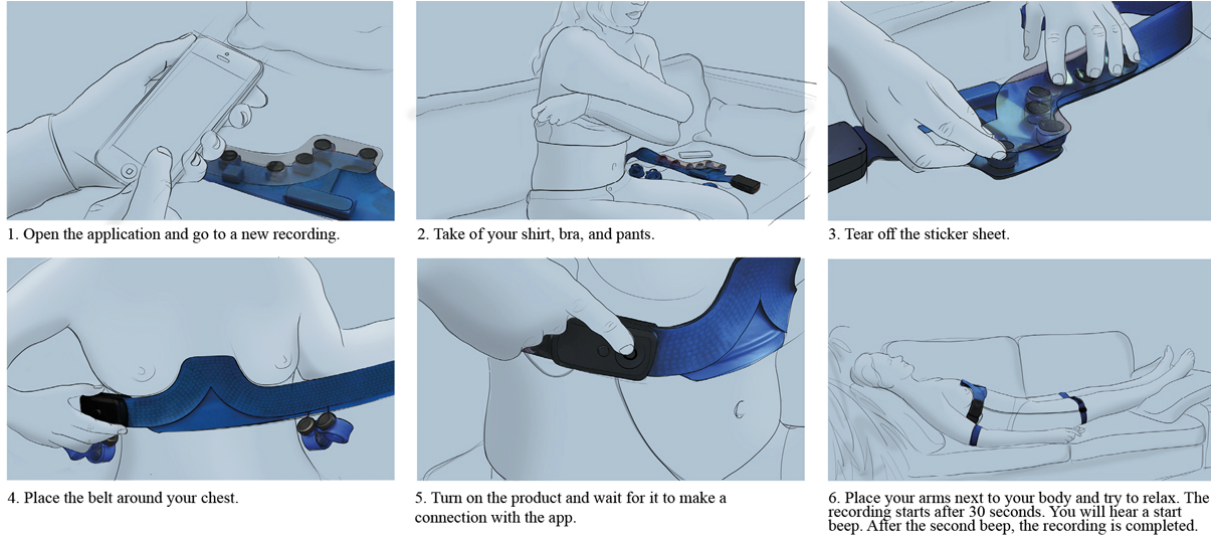
Figure 10. A selection of steps from the manual.